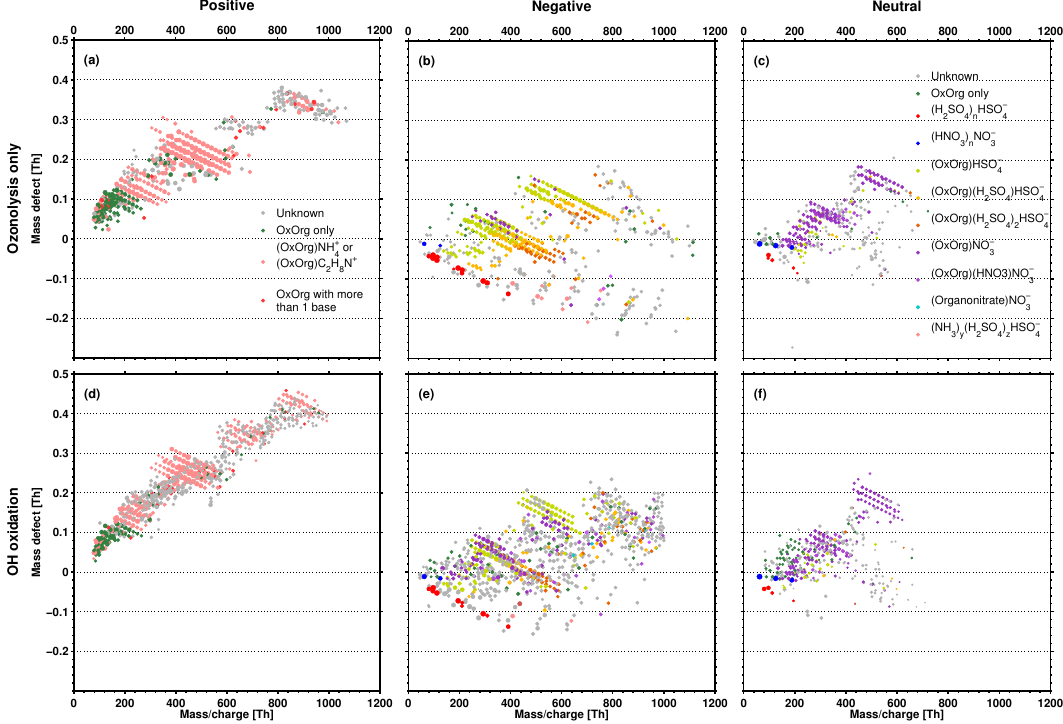
Figure 2. Mass defect plots derived from detected cations (positive APi-TOF, a and d ), anions (negative APi-TOF, b and e ), and neutral molecular clusters (CI-APi-TOF, c and f ) of α -pinene ozonolysis with OH scavenger (a – c) and α -pinene oxidation by OH only (d – f) . The legend in (a) applies to panel (d) as well, while the legend in (b) applies to (c) , (e) , and (f) as well.